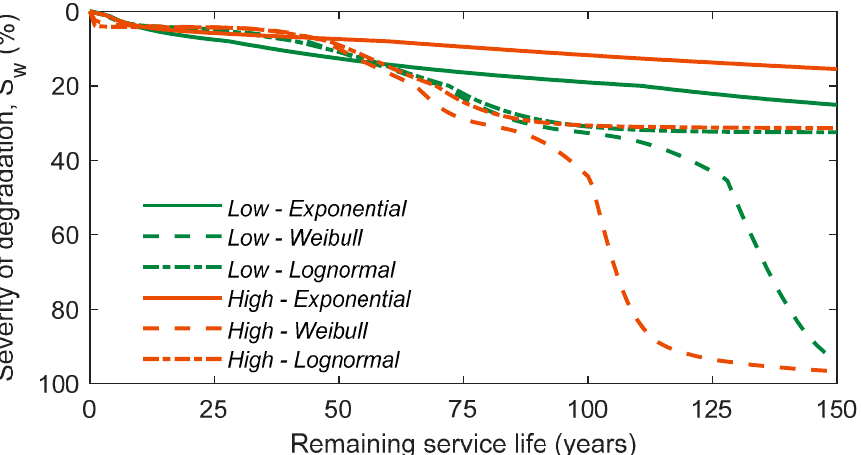
Figure 9. Comparison of the average degradation curves obtained for the three probabilistic distributions and for both heights.